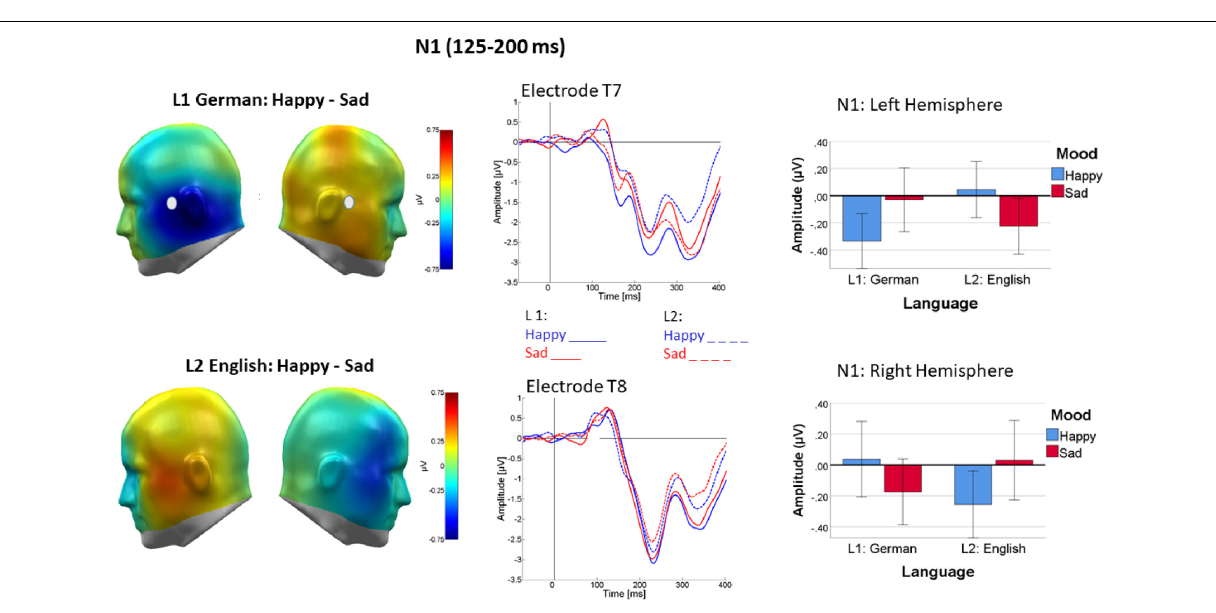
44) = 2.5, p = 0.09, η p2 = 0.1]. In particular, negativity